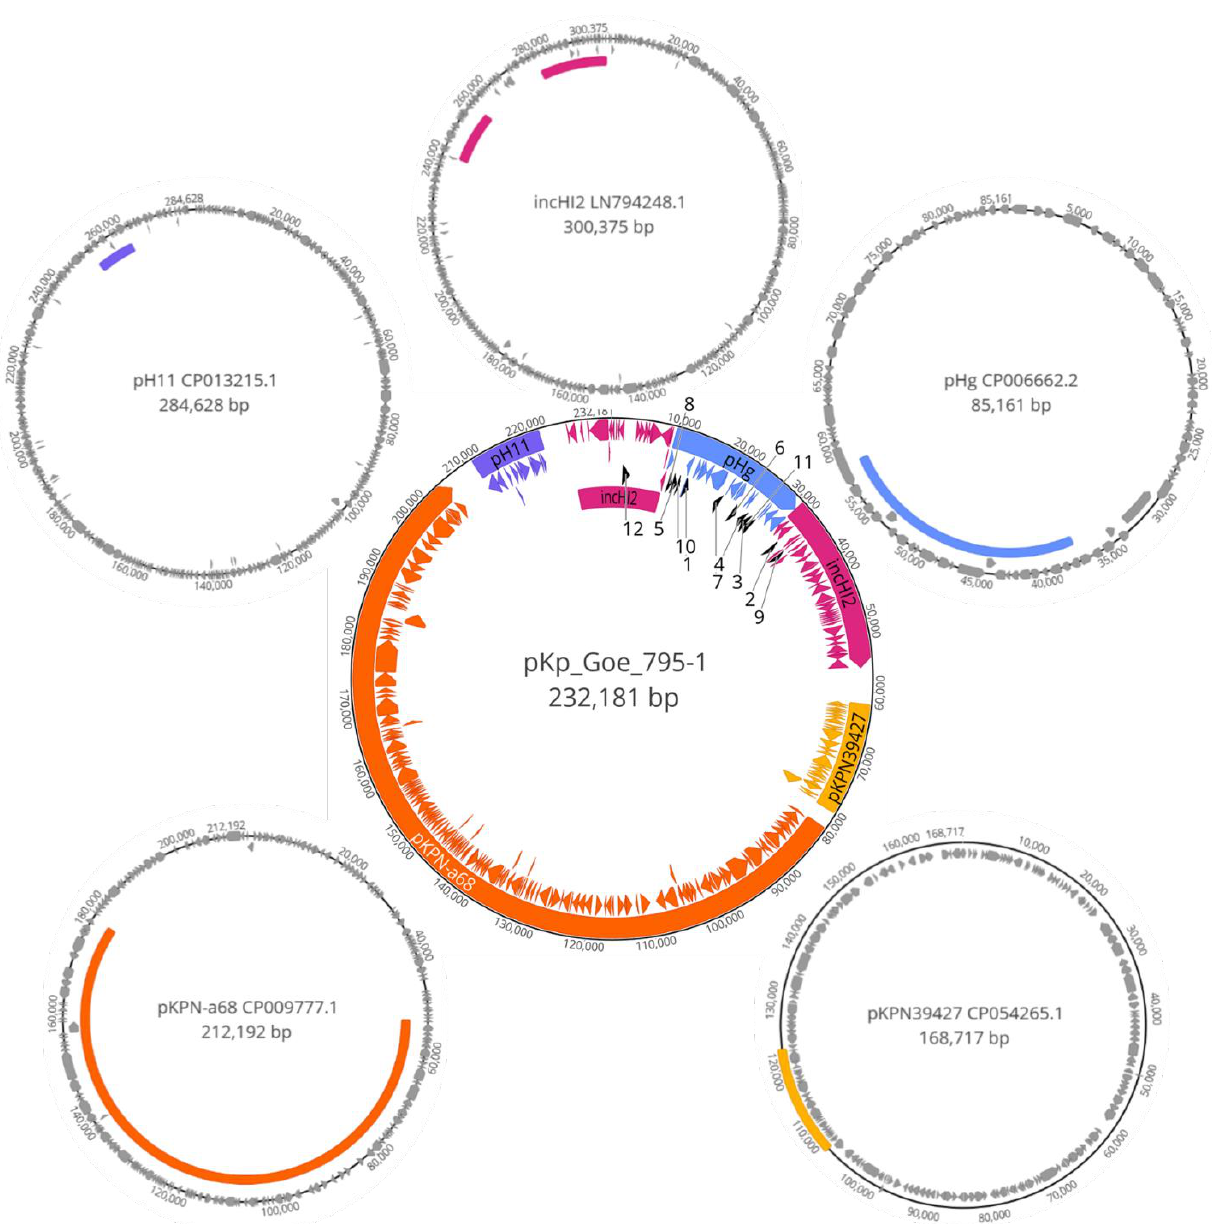
Figure 3. Plasmid chimaera pKp_Goe_795-1 and possible origins. Plasmid pKp_Goe_795-1 (CP018460) was isolated from strain Kp_Goe_39795 of sequence type ST15. Mapped regions had an identity of >98% with correspondingly colored areas from putative origins and a minimal length of 10 kbp. Regions found include plasmids pHg (CP006662), pKPN39427 (CP054265), pKPN-a68 (CP009777), pH11 (CP013215), as well as two disjointed regions from plasmid incHI2 (LN794248). Resistance genes as predicted by ResFinder: 1: aac (3)-IIa, 2: ant (3′’)-Ia, 3: aph (3′’)-Ib, 4: aph (6)-Id, 5: bla OXA - 1 , 6: bla TEM - 1B , 7: bla CTX - M-15 , 8: aac (6′)-Ib-cr, 9: catA 1, 10: catB 3, 11: sul 2, 12: tetA .